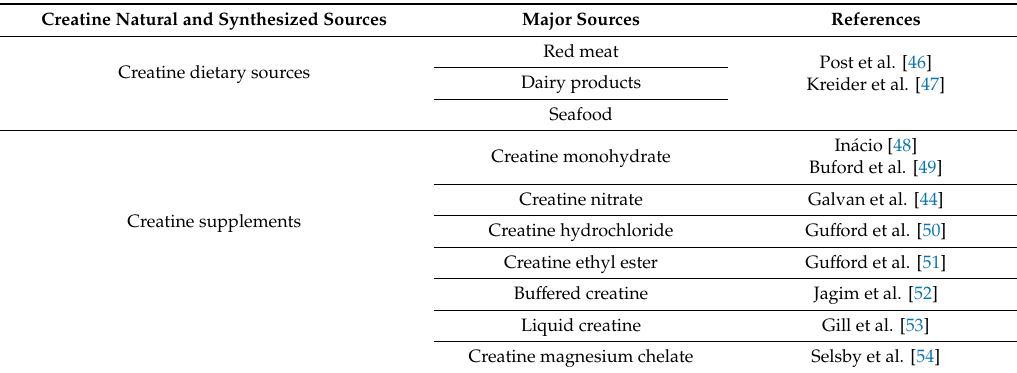
Table 1. Major dietary sources of